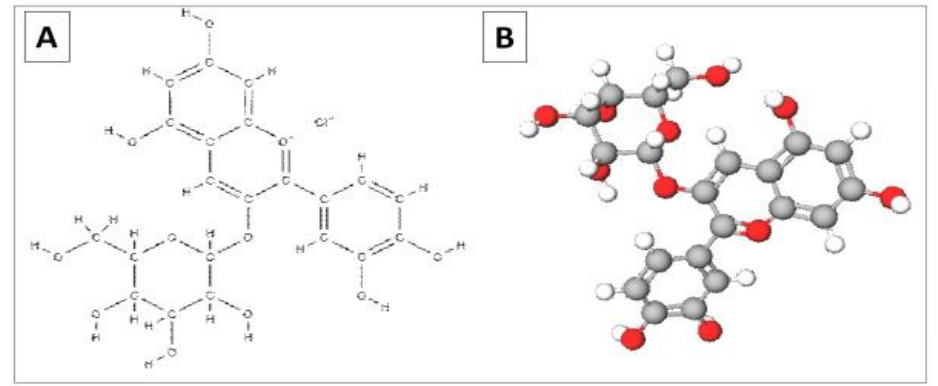
Figure 1. Structure of anthocyanin (cyanidin-3-glucoside). ( A ): 2D structure; ( B ): 3D structure. Created with https://molview.org/ (Acessed on 12 March 2023).